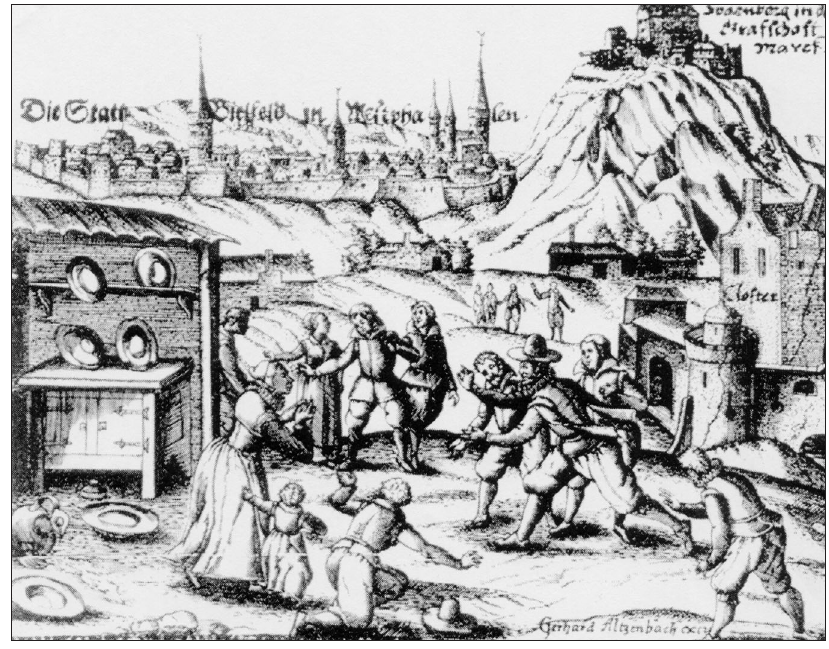
Fig. 3. Contemporary engraving showing the effects of the 1612 Bielefeld earthquake - frightened people, falling pewter ware and damaged buildings ( cf. Vogt and Grünthal,